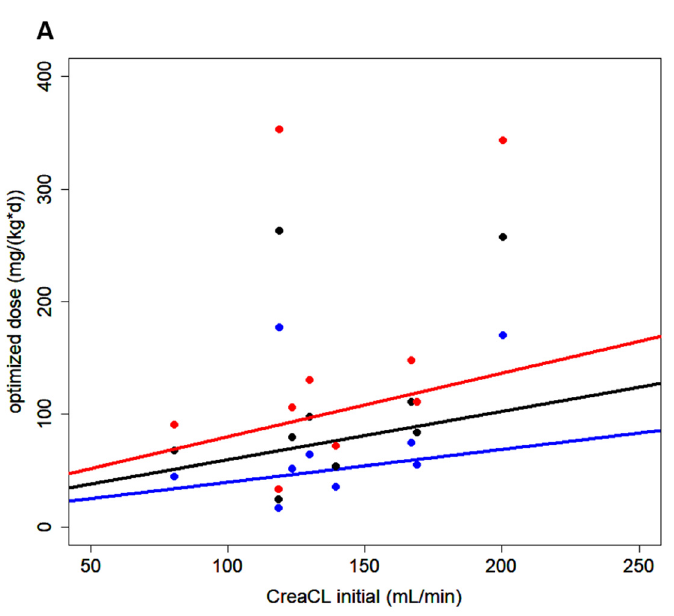
Figure 5. Nomogram for initial dosing of meropenem. Nomogram depicting the daily doses of continuous infusion meropenem required to achieve specific target concentrations in CSF (2, 3, and 4 mg/L) given different creatinine clearance values (CreaCL, calculated according to Cockcroft and Gault). Blue, black, and red lines and dots represent calculated doses for target CSF concentrations of 2, 3, or 4 mg/L,